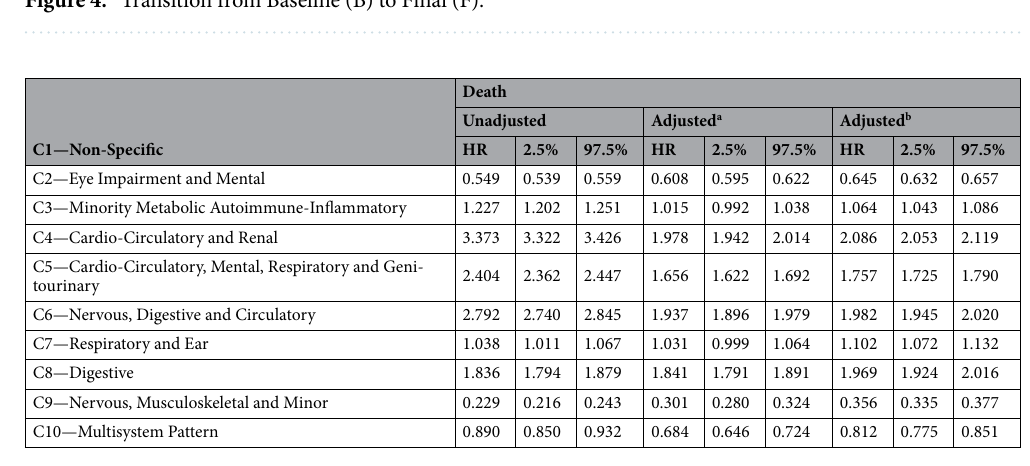
Table 2. Cox proportional-hazards regression for mortality cluster. HR hazard ratio. a Sex, Age, MEDEA (Complete Cases). b Sex, Age, MEDEA (Multiple